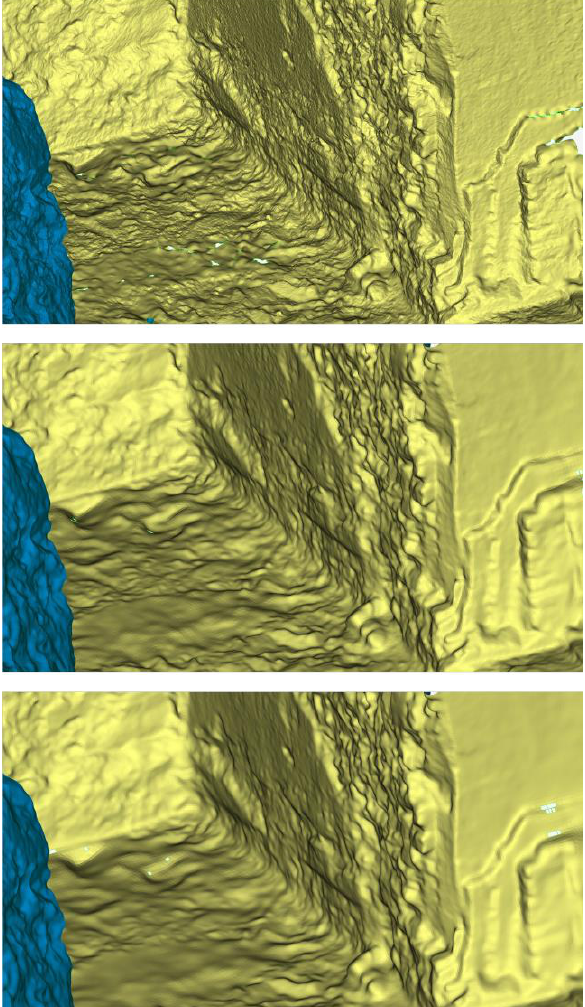
Figure 4. Reconstruction results: VCG (top), Poisson (middle), and Out-of-core Poisson